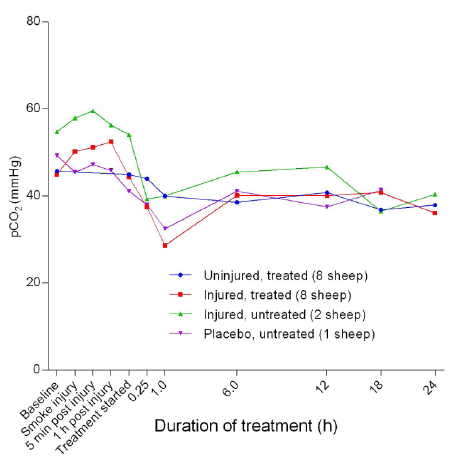
Figure 6. Mean arterial carbon dioxide partial pressure (pCO (Mean ± SD) in smoke and non-smoke injured sheep that received extracorporeal life support as compared to that in untreated controls. Error bars have been omitted for clarity.